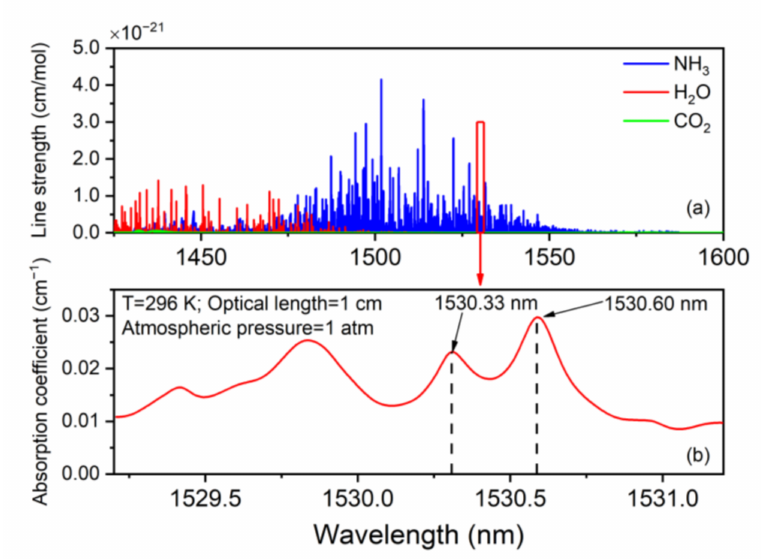
Figure 2. Simulation absorption spectra based on HITRAN database: ( a ) absorption line strength of different gases; ( b ) absorption coefficient of NH 3 at 296 K, standard atmospheric pressure, and an optical path length of 1 cm for 10,000 ppm NH 3 :N 2